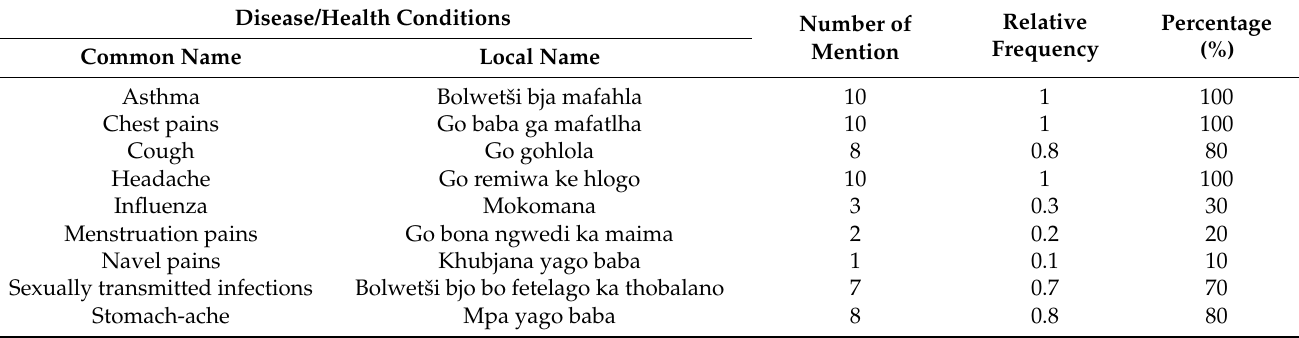
Table 2. Medicinal uses of African ginger in the two selected communities of Bushbuckridge local municipality, Mpumalanga province, South Africa (n =